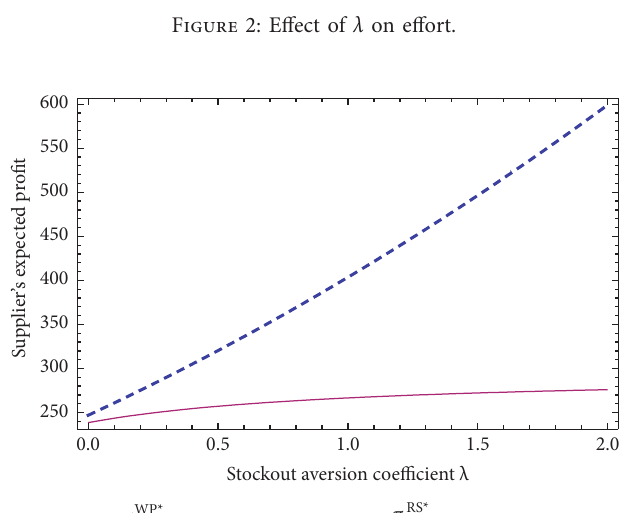
Figure 3: Effect of λ on supplier’s expected